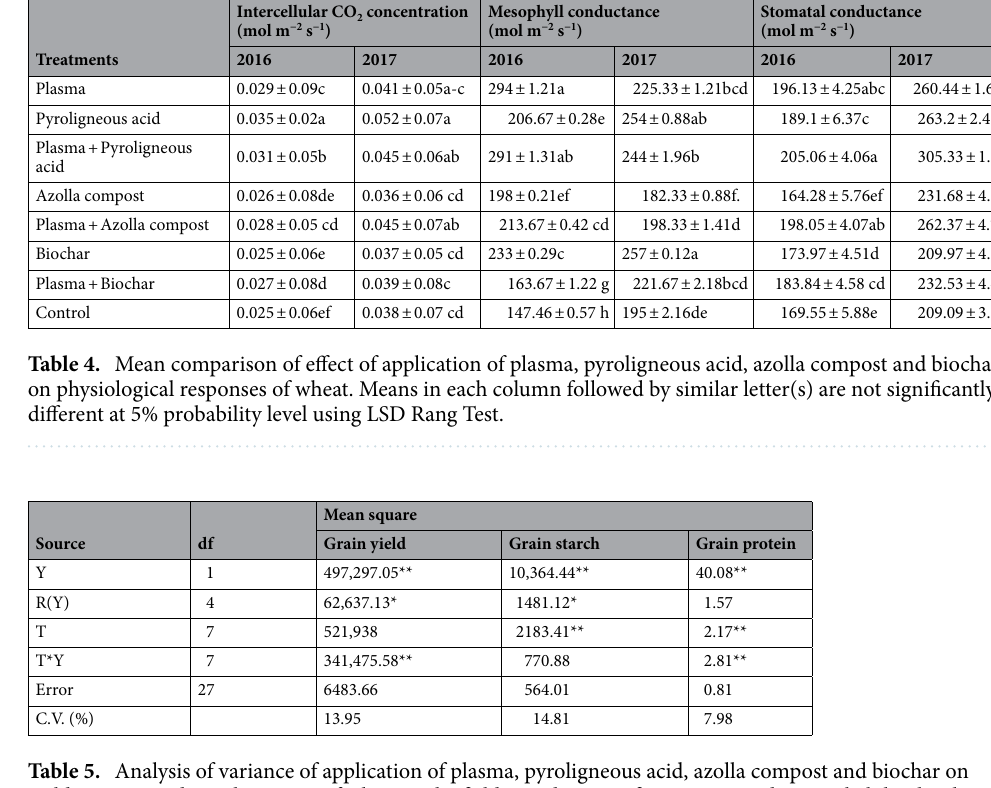
Table 5. Analysis of variance of application of plasma, pyroligneous acid, azolla compost and biochar on yield, protein and starch content of wheat in the field. * and ** Significant at 5% and 1% probability levels, respectively. Y, year; R(Y), replication year; T, treatments; T*Y, interaction between treatments and years; df, degree of freedom; C.V., coefficient of variation.